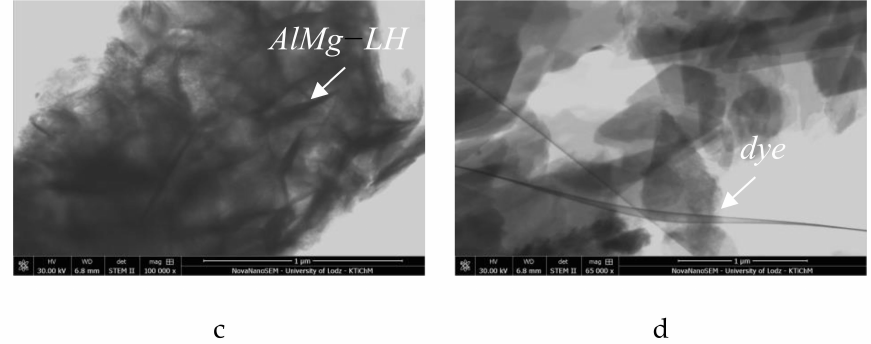
Figure 7. Scanning transmission electron microscope STEM micrographs of AlMg − LH ( a , c ) and AlMg − LH/AD 10% ( b , d ).